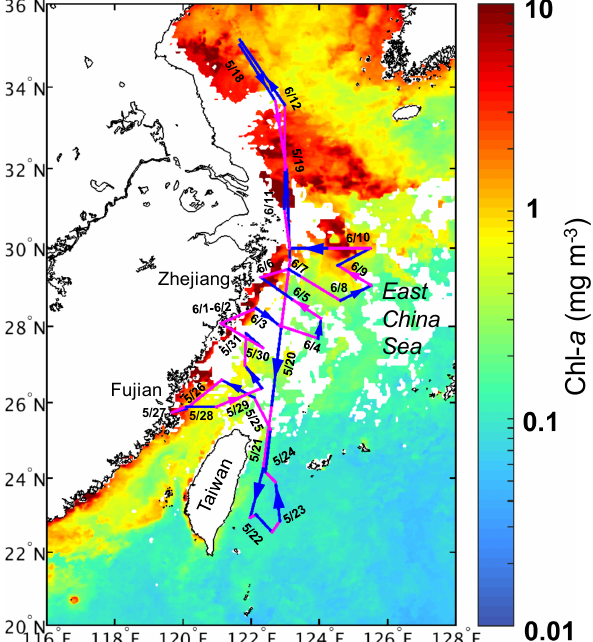
Figure 1. Cruise tracks of KEXUE-1 and spatial distribution of satellite-derived chlorophyll- a concentrations (chl- a , mgm − 3 ) in surface seawater derived from MODIS L3 products during the sam- pling period in the East China Sea. The purple and blue lines repre- sent daytime and nighttime aerosol samples,